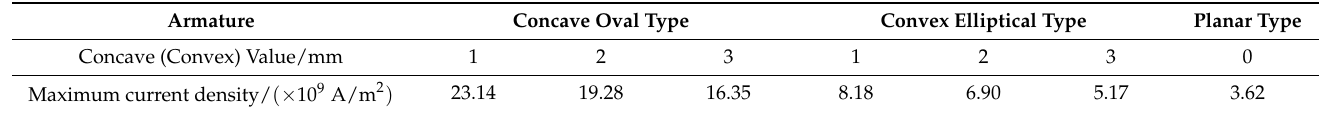
Table 4. Maximum current density of armature contact surface at different concave (convex) values. Armature Concave Oval Type Convex Elliptical Type Planar